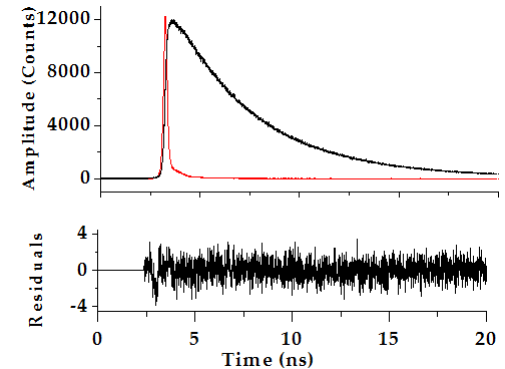
Figure 6. Fluorescence decay curve of complex 5 in DMSO.